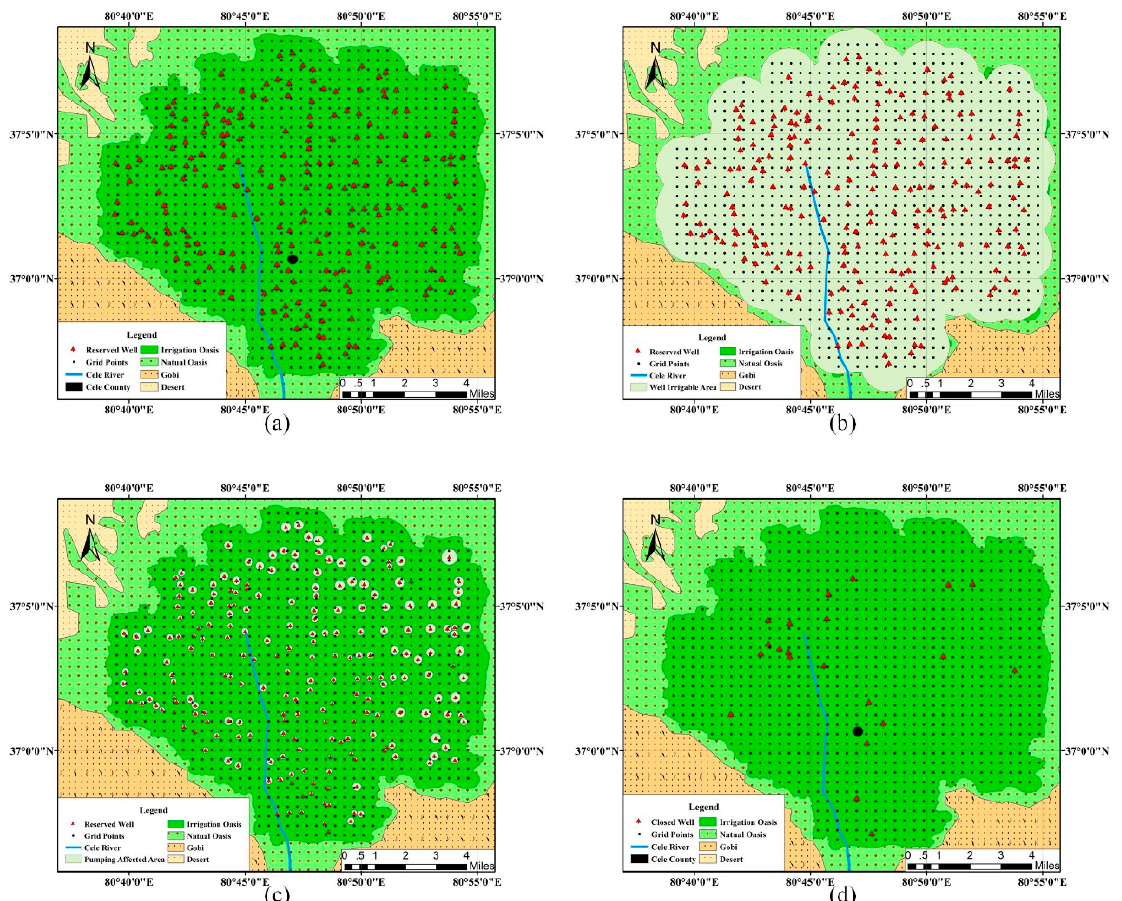
Figure 5. Well layout of explicit cost optimization (ECO) in the Cele Oasis: ( a ) well optimization layout, ( b ) well optimization irrigation radius layout, ( c ) well optimization influence radius layout, and ( d ) recommended closed well layout.